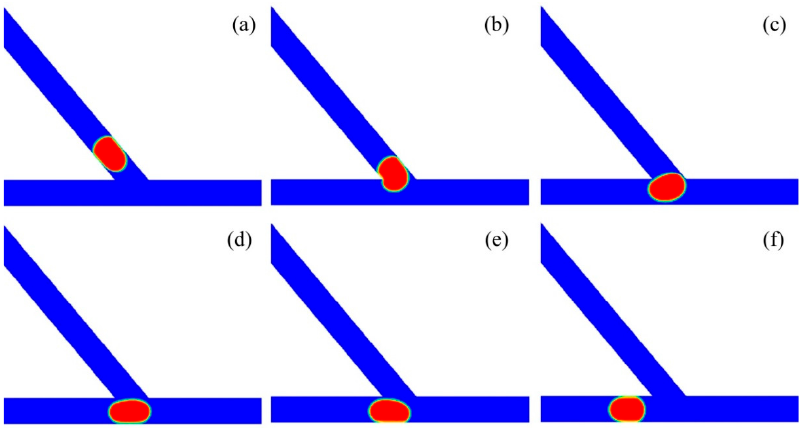
Figure 4. Passive sorting of large droplet into the left channel ( θ = 50°, U = 20 mm/s, V d /w 3 = 0.85). ( a ) T0, ( b ) T1 = T0 + 0.8, ( c ) T2 = T0 + 1.4, ( d ) T3 = T0 + 1.8, ( e ) T4 = T0 + 2.8, ( f ) T5 = T0 + 4.8.